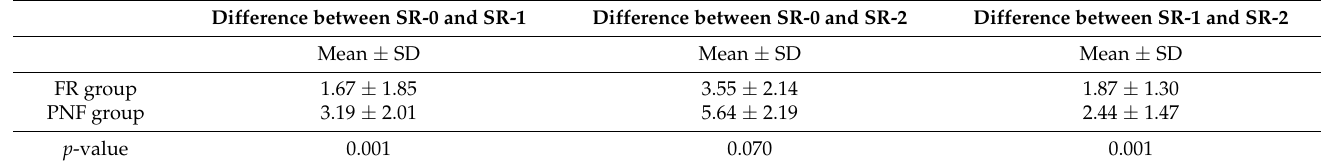
Table 3. Hamstring flexibility. Inter-group